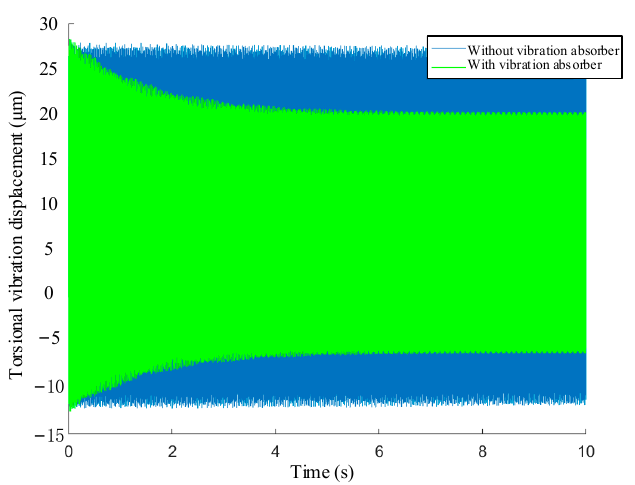
Figure 5. Two modes’ vibration displacement (periodical excitation).